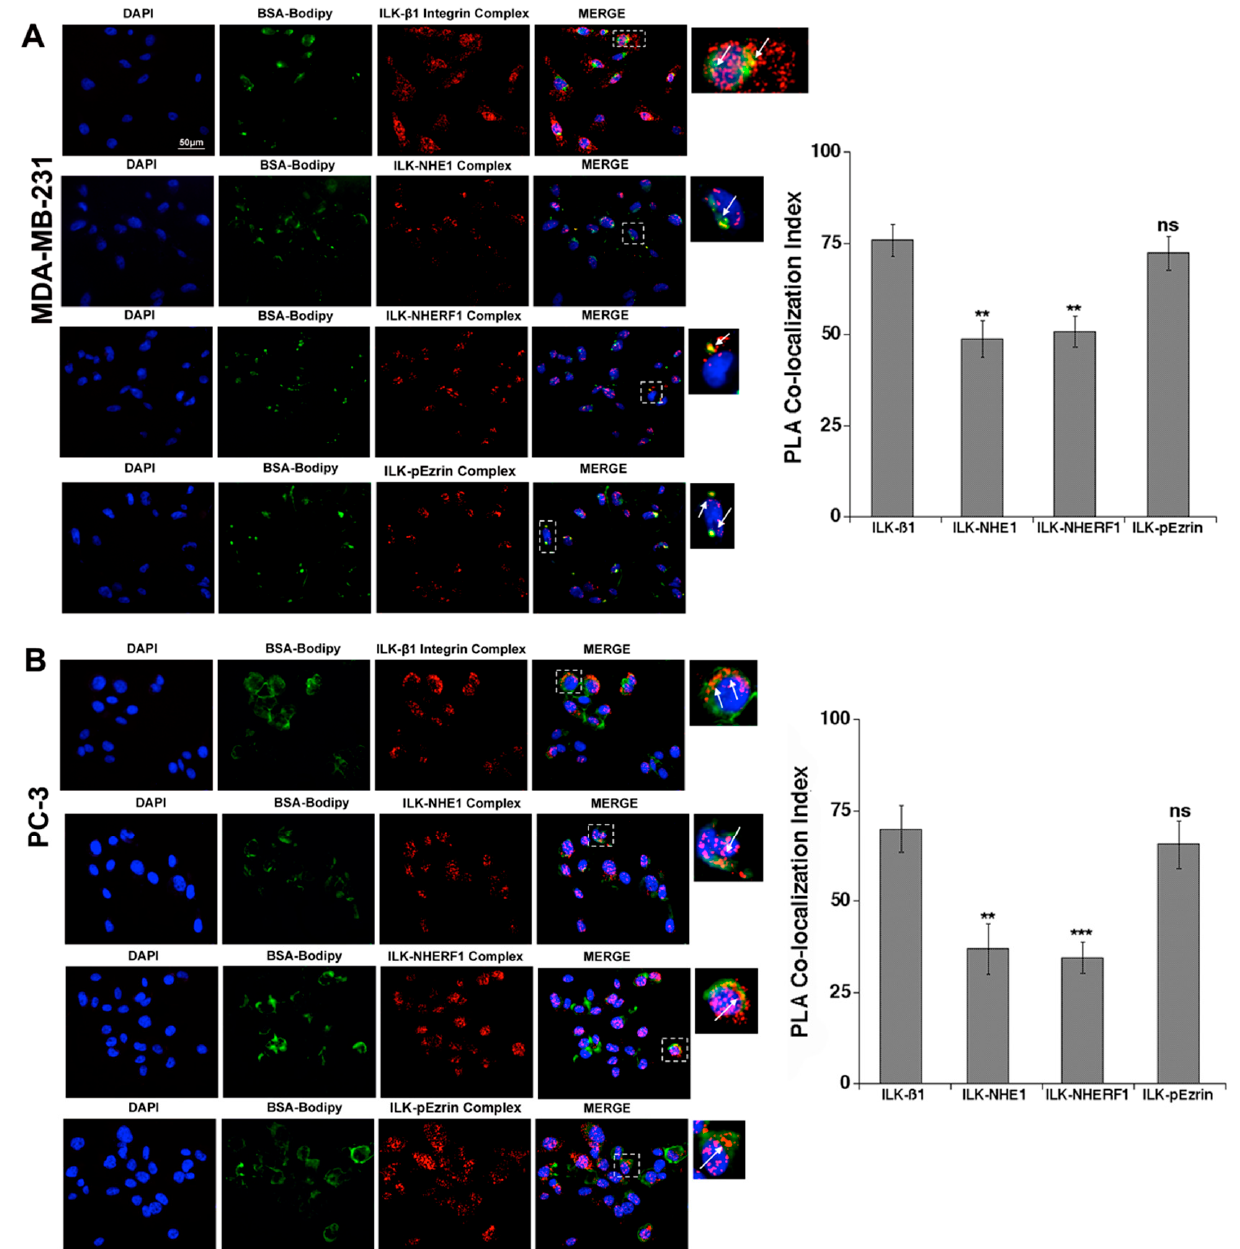
Figure 1. ILK formed protein–protein complexes with β 1-integrin receptor, p-ezrin, NHERF1 and NHE1 in areas of focal digestion of Matrigel in MDA-MB-231 ( A ) and PC-3 ( B ) cells. To better visualize invadopodial focal digestion and protein–protein complex localization in Matrigel, we utilized PLA for each protein–protein complex together with in situ zymography using the quenched fluorescent substrate, DQ Green-BSA. Therefore, quantifiable fluorescence was released only upon digestion of the matrix. After the cells digested the fluorogenic substrate (green), the cells were fixed for subsequent PLA analysis (red). The white arrows indicate areas of co-localization of BSA-Bodipy with the PLA signal. The histograms display the analysis of co-localization of ILK with the other proteins (PLA co-localization index) in the specific area of focal proteolysis in ECM digesting cells. Mean ± S.E.M., n = 6, ns: non-significant, ** p < 0.01, *** p < 0.001 for co-localization index compared to the ILK- β 1 PLA analysis.